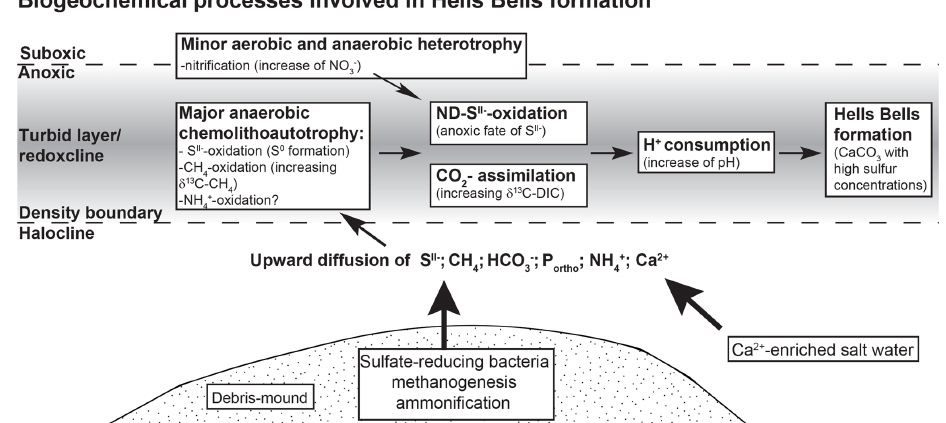
Figure 9. Scheme of the biogeochemical processes involved in the sediment and redoxcline of the water column of the El Zapote cenote that lead to Hells Bells